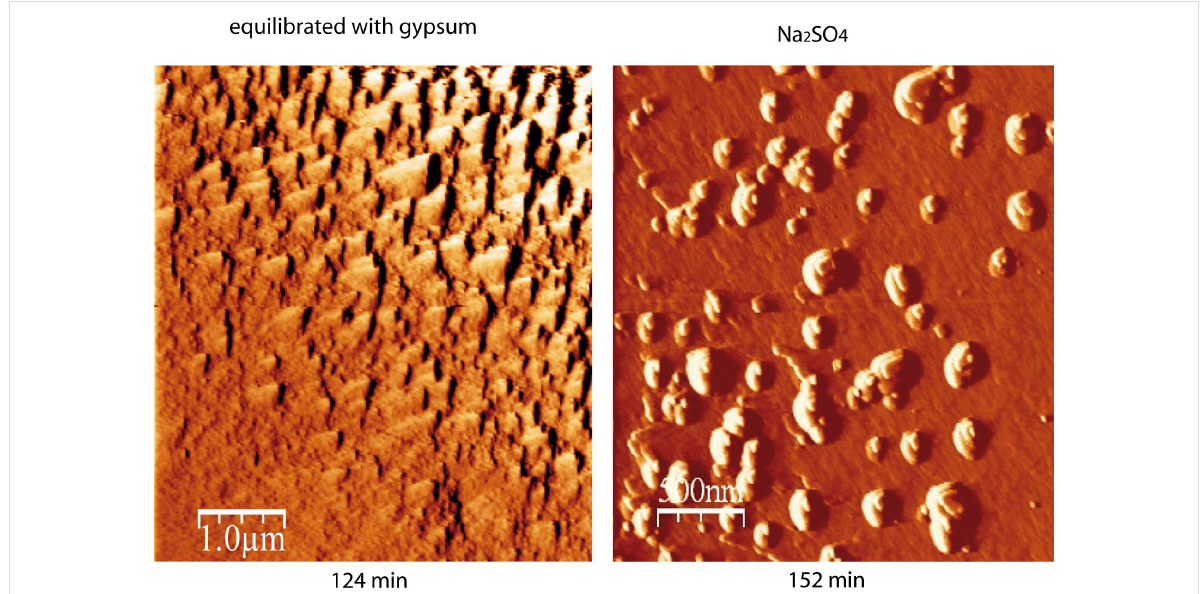
Figure 7: Gypsum precipitation on a calcite surface at pH 3: a) Experiment with gypsum equilibrated CaSO 4 solution: homogeneous, arrow-type gypsum growth on the cleavage calcite surface; b) Experiment with Na 2 SO 4 solution: random protuberances over the calcite surface.